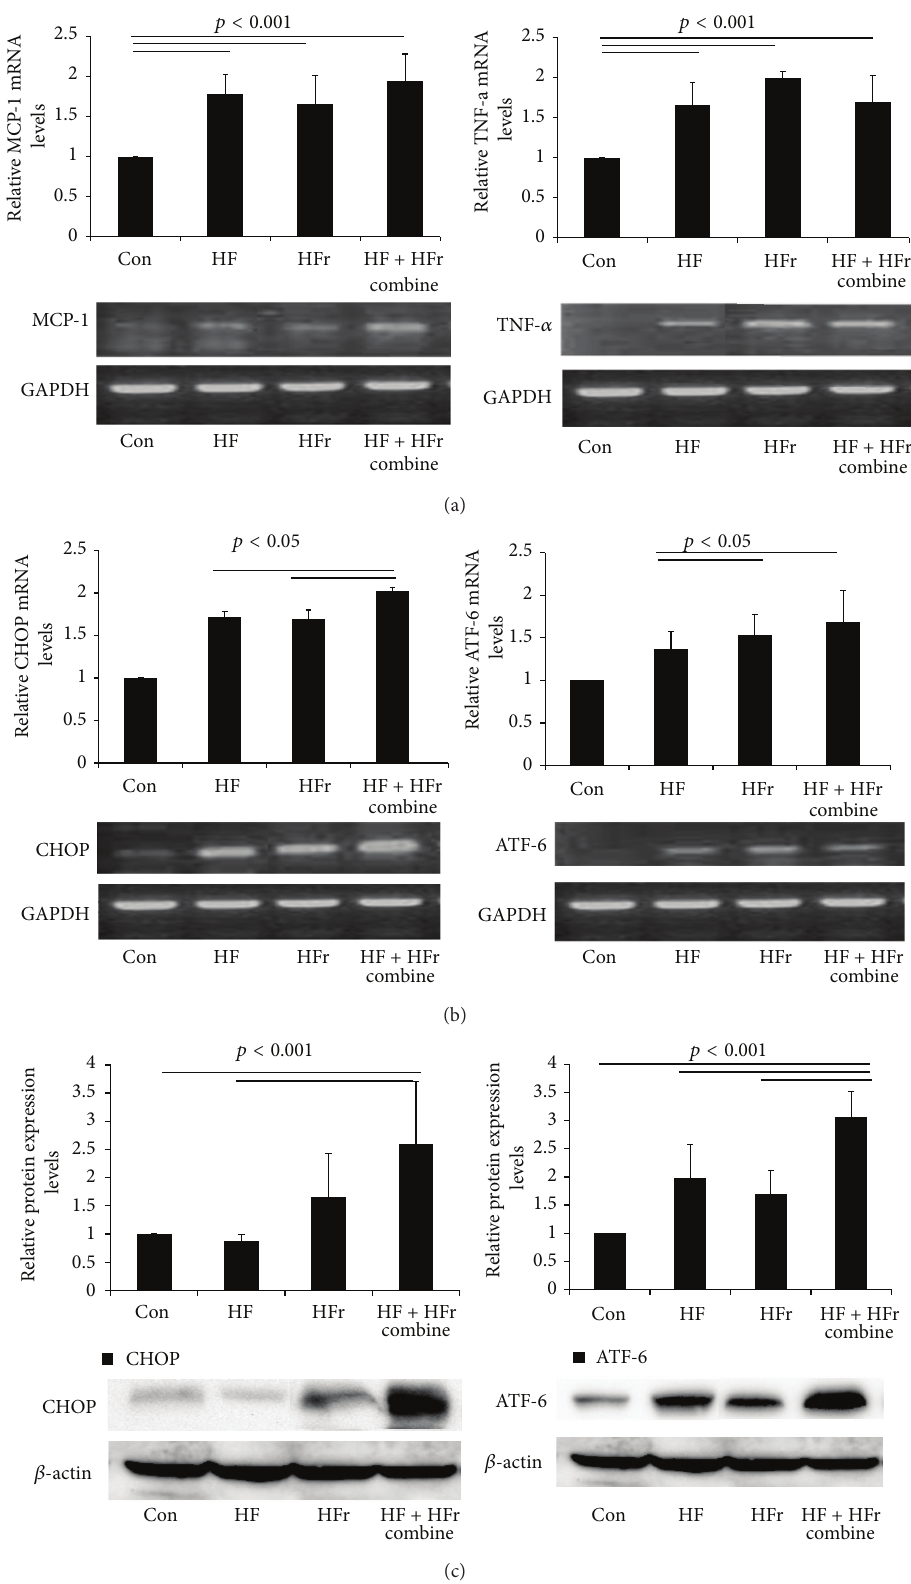
Figure 4: Changes in hepatic expression of genes involved in endoplasmic reticulum stress, inflammation, and insulin resistance. Gene expressionofinflammationmarkersintheliverfromeachgroupwasinvestigatedbyRT-PCRanalysis(a).Detectionofendoplasmicreticulum stress markers in the liver from each group using RT-PCR (b). Detection of CHOP and ATF-6 in the liver from each group using western blotting (c). 𝑁 = 3 ∗ 𝑝 < 0.05 by